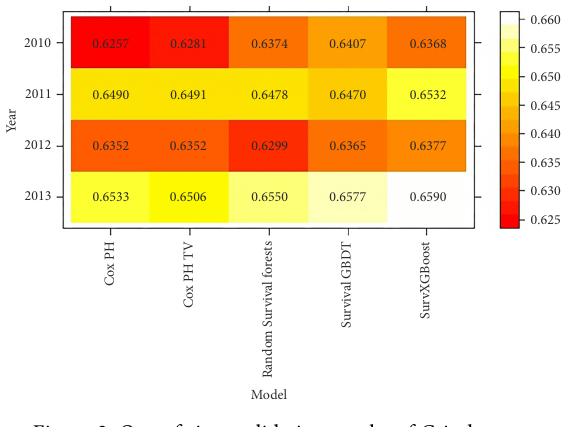
Figure 2. Out-of-time validation results of C-index